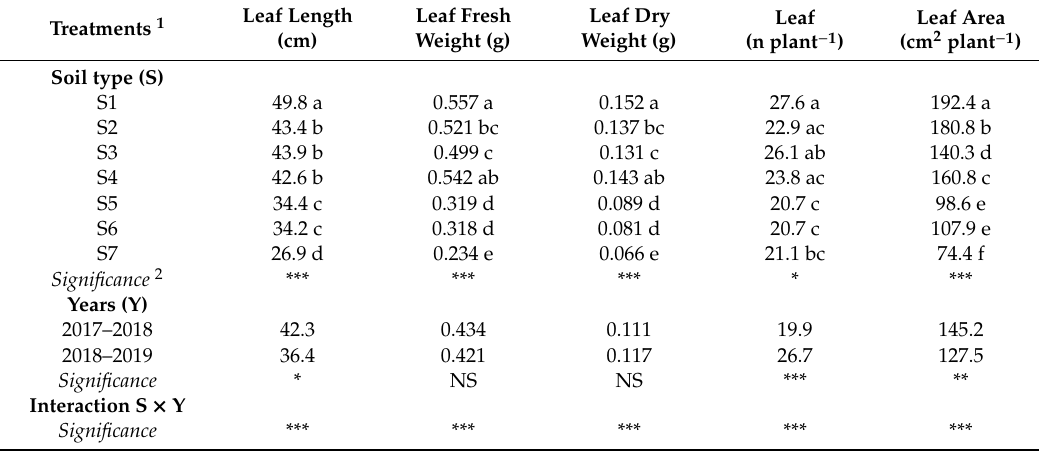
Table 5. E ff ects of the soil type on leaf traits of sa ff ron in two